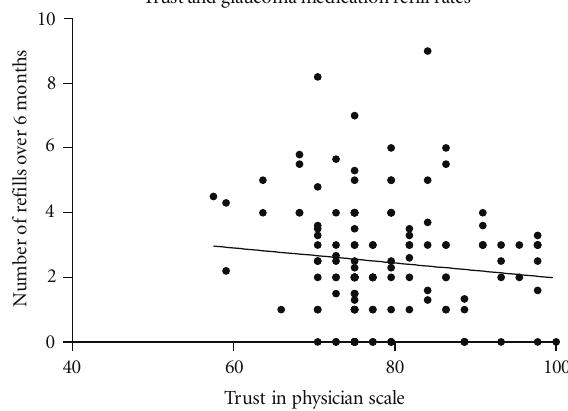
Figure 2: Number of refills for glaucoma medications requested by the 142 subjects for whom such data were available were plotted against scores on the Trust in Physician Scale. Little of the variability in refill rates, a surrogate marker for medication adherence, is explained by trust in this model ( R 2 = 0 . 01, P = .